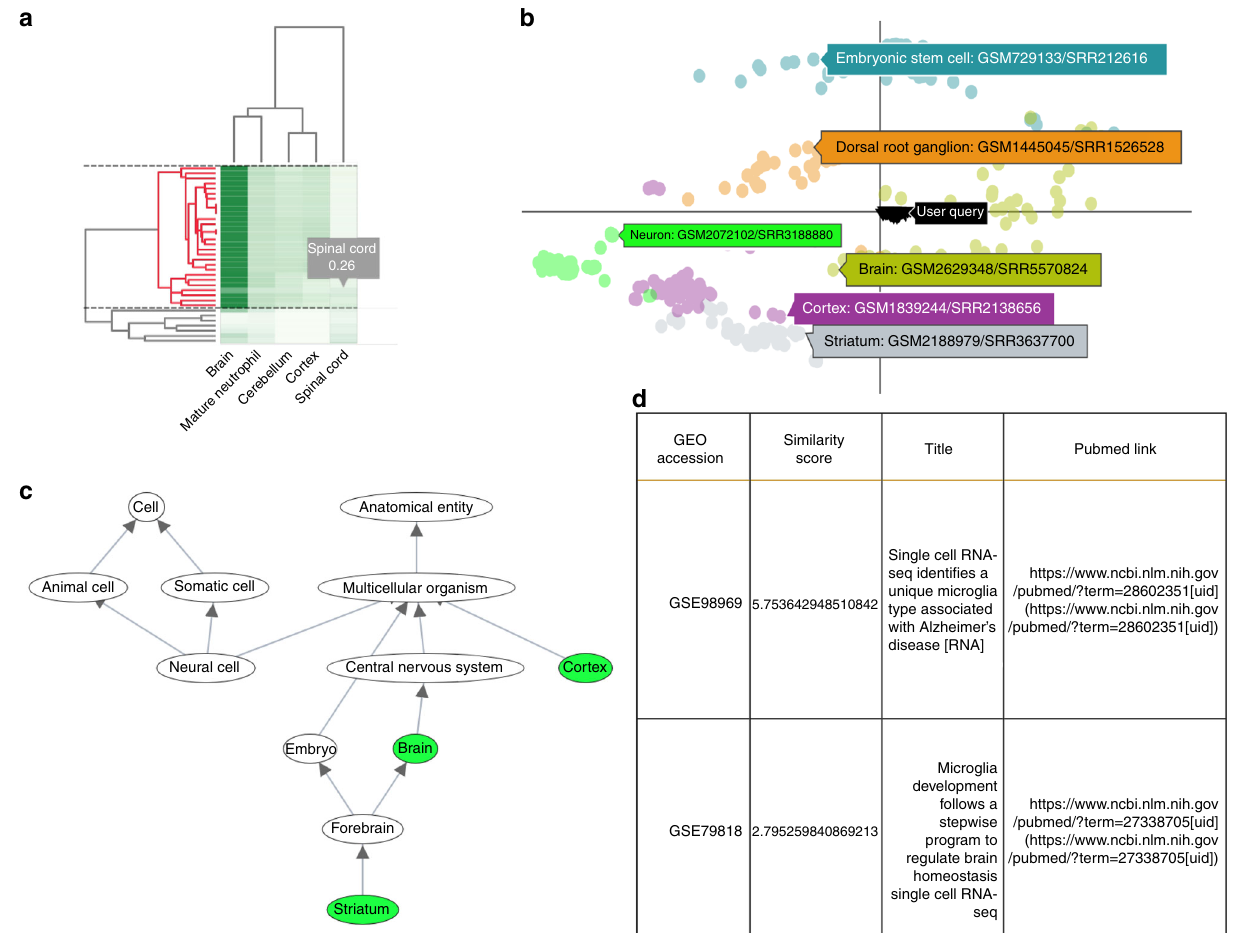
Fig. 5 The scQuery web server. a Cluster heatmap of the nearest neighbor results for a query consisting of 40 “ brain ” and 10 “ spinal cord ” cells. The horizontal dashed lines demarcate the currently selected cluster and the corresponding dendrogram sub-cluster is highlighted in red. b 2D scatter plot of the selected sub-cluster (shown as inverted triangles and tagged as “ User Query ” ) along with a handful of other cell types whose tags show cell-type information and GEO submission ids for a single cell from each cluster. c Ontology DAG depicting the retrieved cell types in green while the nodes in gray visualize the path to the root nodes (which re fl ects paths of cellular differentiation as well as other biological relationships). d Metadata table for the retrieved hits displaying the GEO accession id, similarity score, publication titles, and their respective pubmed